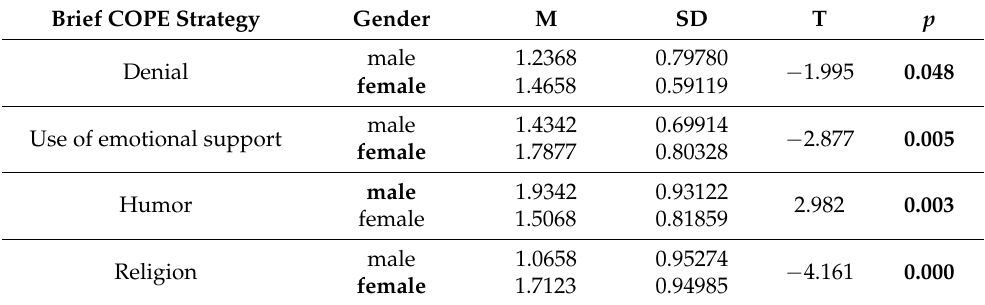
Table 3. Gender differences in the preference for coping strategies between business